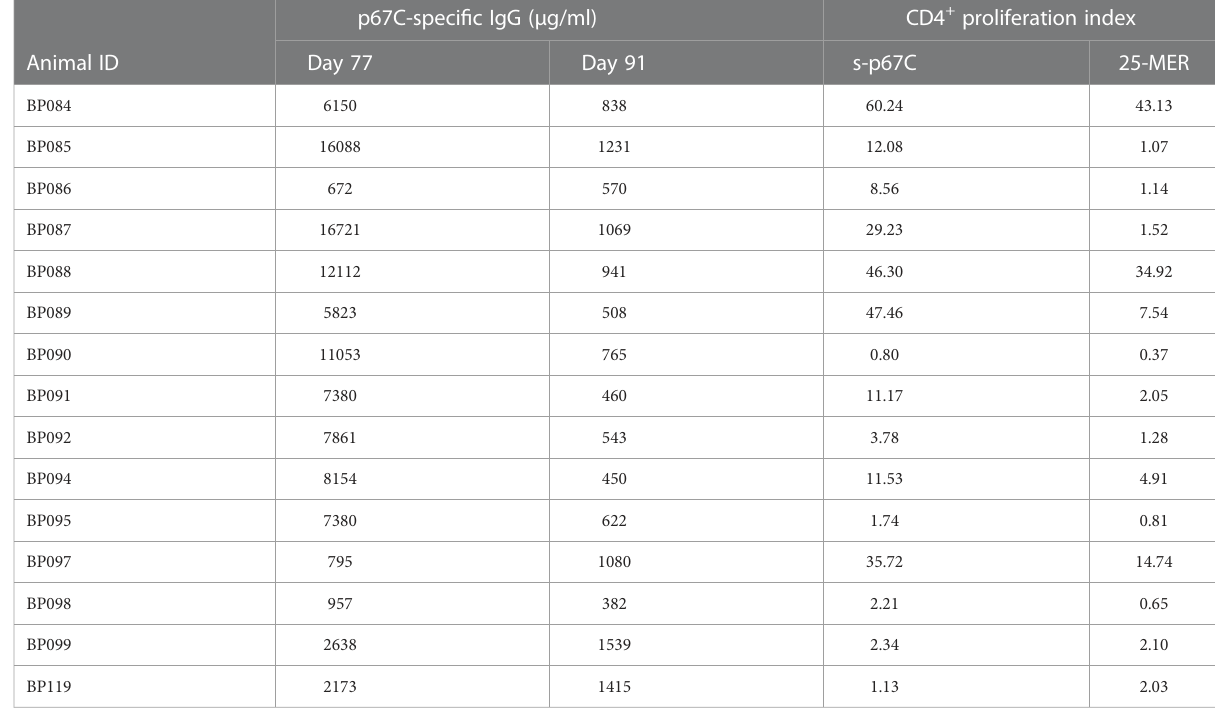
TABLE 4 Summary of immune parameters measured in Group 6 (challenge experiment).